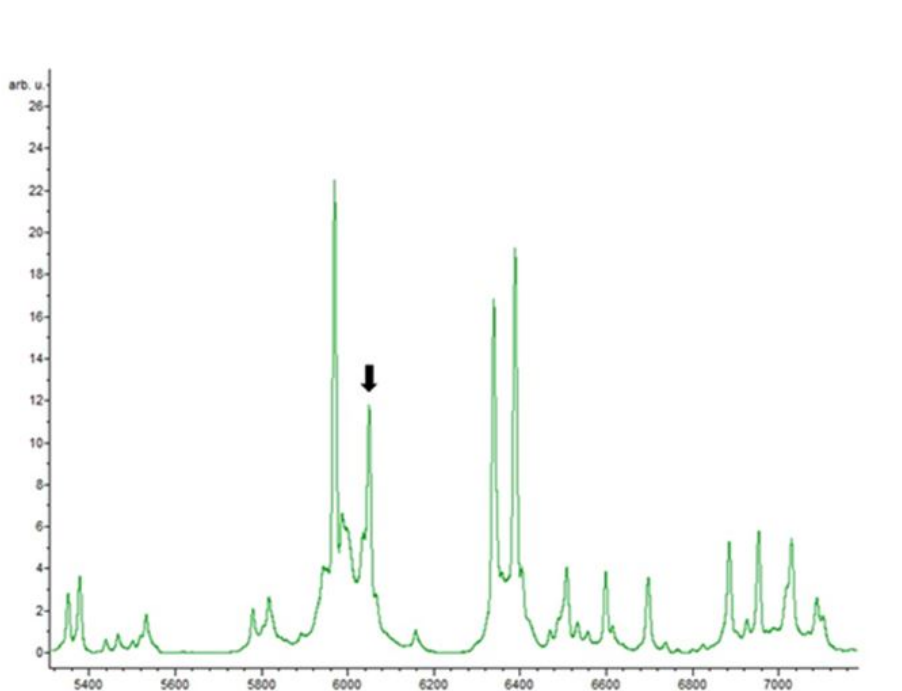
Figure 2. Enterococcus faecium spectrum showing the peak m/z 6048 ± 1 ( p -value is 0.00001) characteristic of these strains.